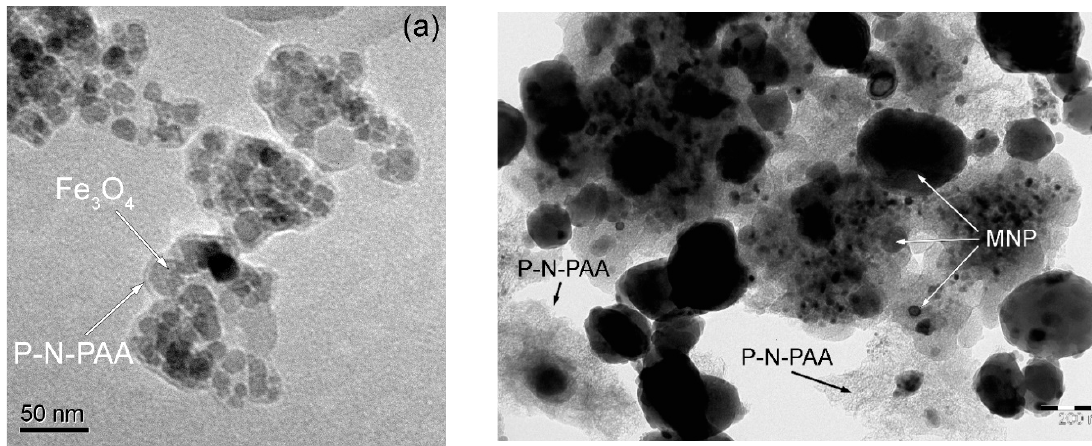
Figure 7. TEM images of Fe 3 O 4 /P ‐ N ‐ PAA ( a ) and MNP/P ‐ N ‐ PAA ( b ).